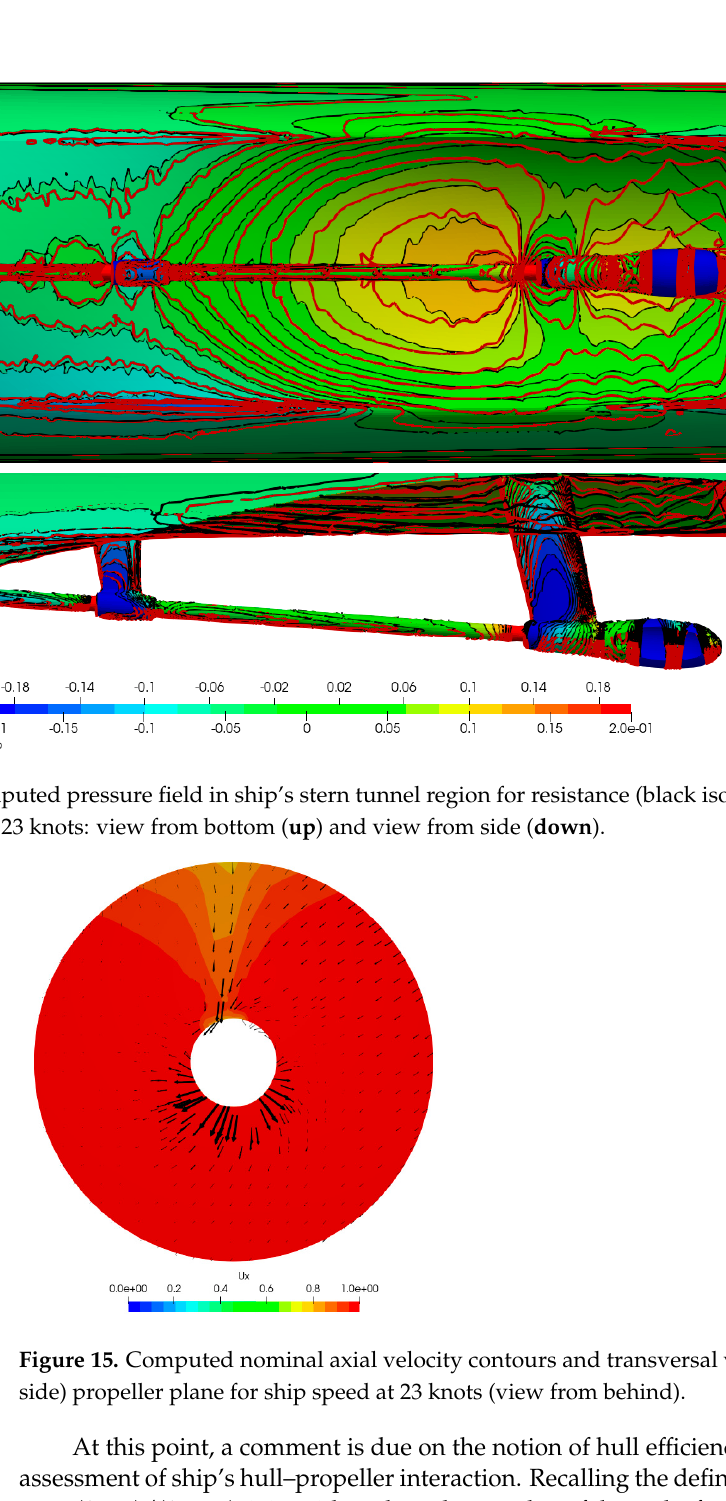
12 of 15 Figure 13. Taylor wake fraction ( left ) and thrust deduction factors ( right ) from model tests and full scale CFD (two analysis methods) for the Stavanger Demonstrator . The calculated pressure field in the transom stern area, when looking from the bot-